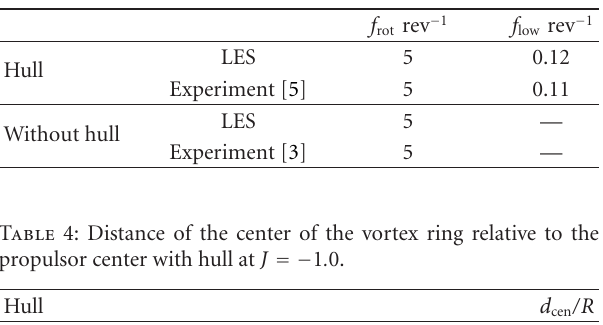
Table 3: Computed and experimental values of peak frequencies of J = − 1 . 0. K H w/ and w/o hull at